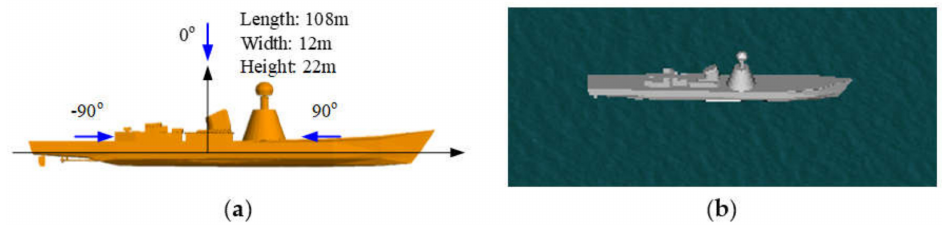
Figure 6. Geometry structure of the ship target 2 ( a ) and the composite scene ( b ).